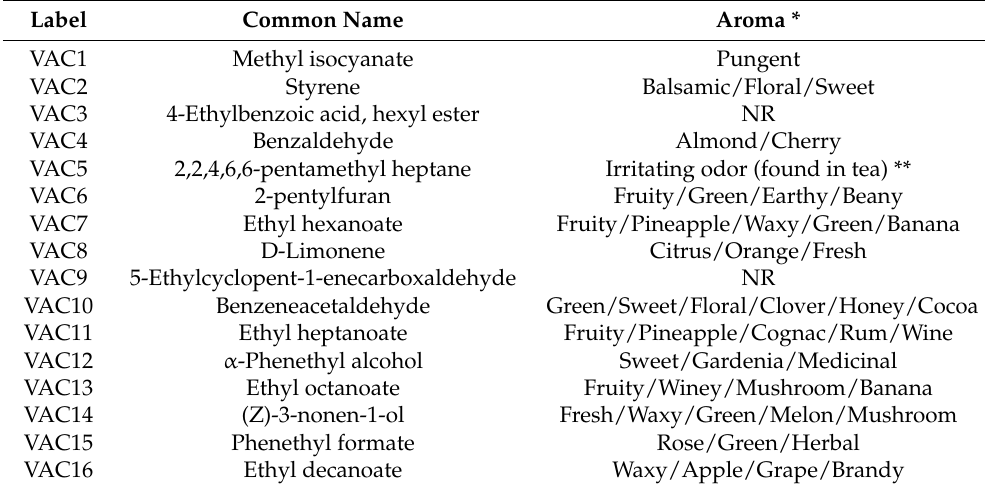
Table 2. Volatile aromatic compounds identified in the sourdough bread samples using gas chromatography-mass